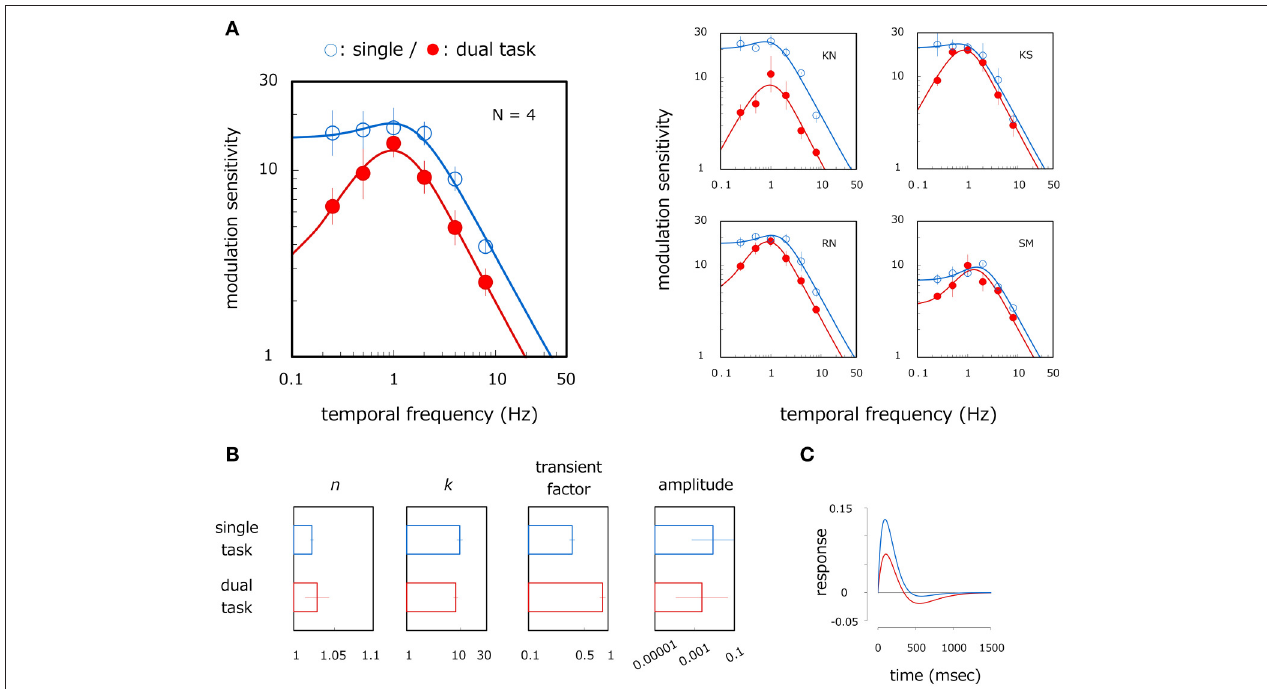
FIGURE 4 | Results of Experiment 2. (A) Velocity modulation sensitivity for different task modes. Left panel shows results averaged across observers. Right panels show results for each observer. Open and filled circles show modulation sensitivity as a function of temporal frequency of velocity modulation for single- and dual-task modes respectively. Each curve represents the fitted MTF. Error bars represent ± 1 SE across observers or 400 bootstrap samples within observer. (B) Estimated parameters of the MTF for single- and dual-task modes. Error bars represent ± 1 SE across observers. (C) Blue and red curves show estimates of temporal impulse response function for the single- and dual-task modes